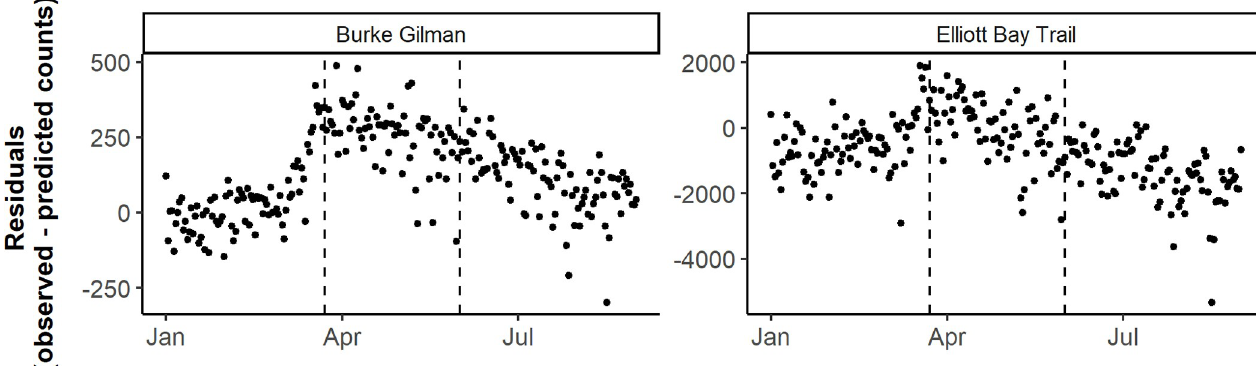
Fig 5. Daily observed minus predicted pedestrian counts by counter location, before, during, and after the Stay Home order in Seattle. The first vertical dashed line corresponds to the Stay Home order on March 23, 2020, and the second vertical dashed line corresponds to the end of the Stay order on May 31, 2020 in Washington state. Note the y-axis scales vary between plots to facilitate the interpretation of results.